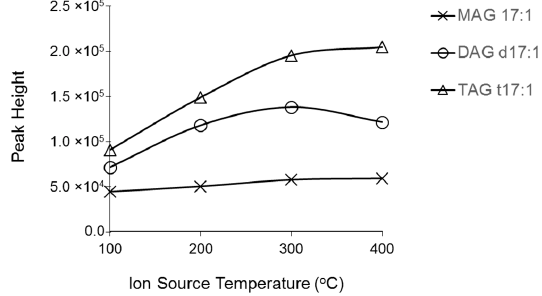
Figure 4. Effects of ESI source temperature on ESI ionization of MAG 17:1, DAG d17:1, and TAG t17:1 at a concentration of 1 µM. Spectra were acquired under the following conditions: GS1 = 10, GS2 = 10, CUR = 15, DP = 100 V.